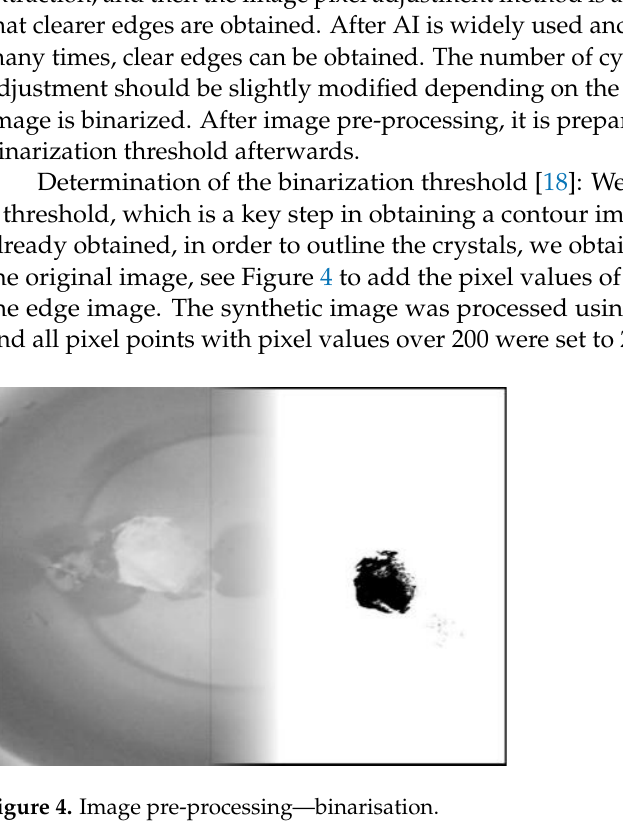
Figure 3. Convolution operation corresponding to the pixel value matrix of the silicon dioxide im- age.